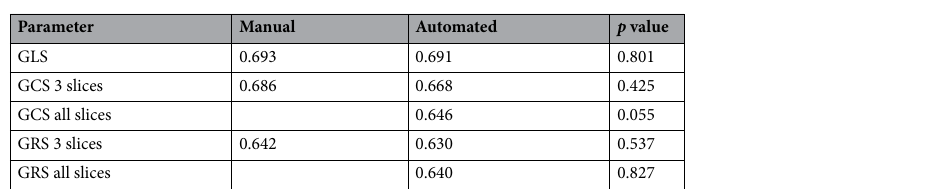
Table 5. AUC in ROC analysis for manual and automated strain values; GLS, GCS 3 slices and GCS all slices, GRS 3 slices and GRS all slices. The AUC was extracted from the ROC graph for manual and automated strain analysis. P was calculated with using the DeLong et al. approach 21 . Automated GCS and GRS all slices were compared to the manual method of obtaining the average of 3 slices. AUC, area under the curve; GCS, global circumferential strain; GLS, global longitudinal strain; GRS, global radial strain. ROC, receiver operating